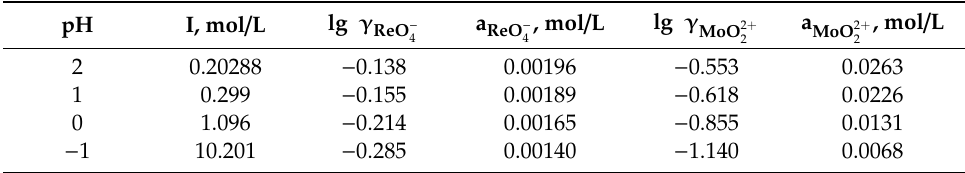
Table A5. Activity coe ffi cients and thermodynamic activities of molybdenum and rhenium species in leaching stock solution at di ff erent pH